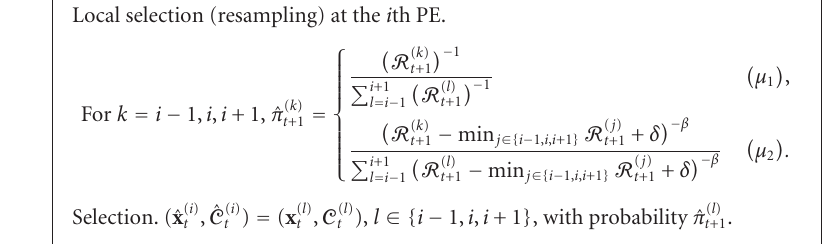
Algorithm 2: Local resampling for the CRPF algorithm.